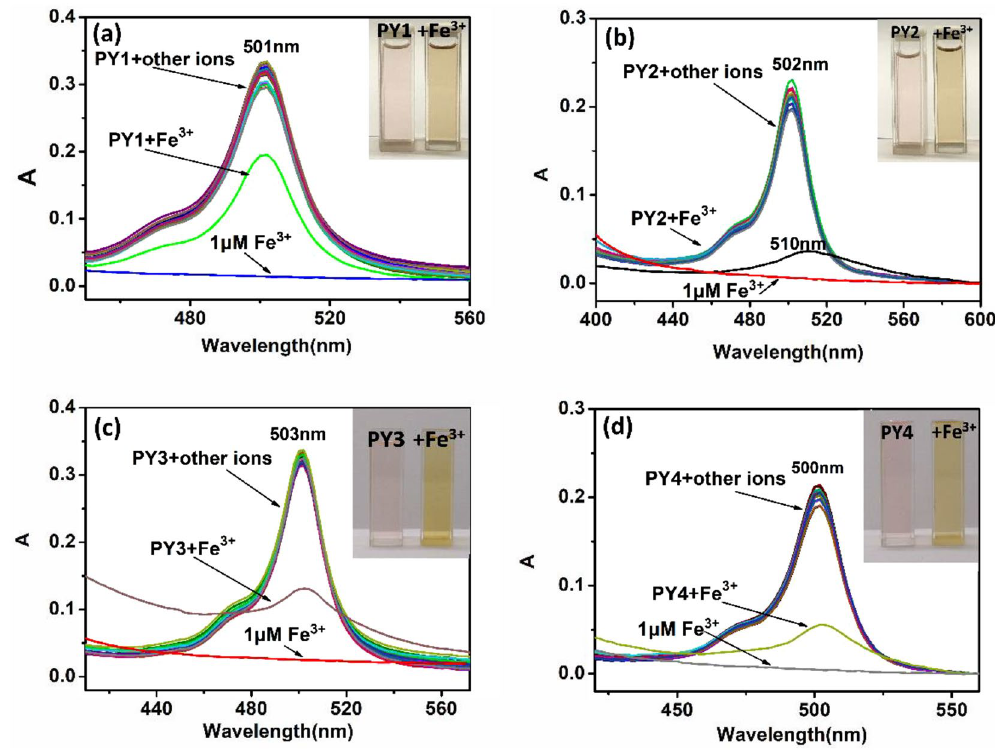
Fig. 3 UV absorption spectra of polymers (1 µM) in the presence of 10 equivalents of metal ions (10 µM) in DMF buffer (pH = 7.0, rt) and pure Fe 3+ solution (10 µM). a PY1, b PY2, c PY3, and d